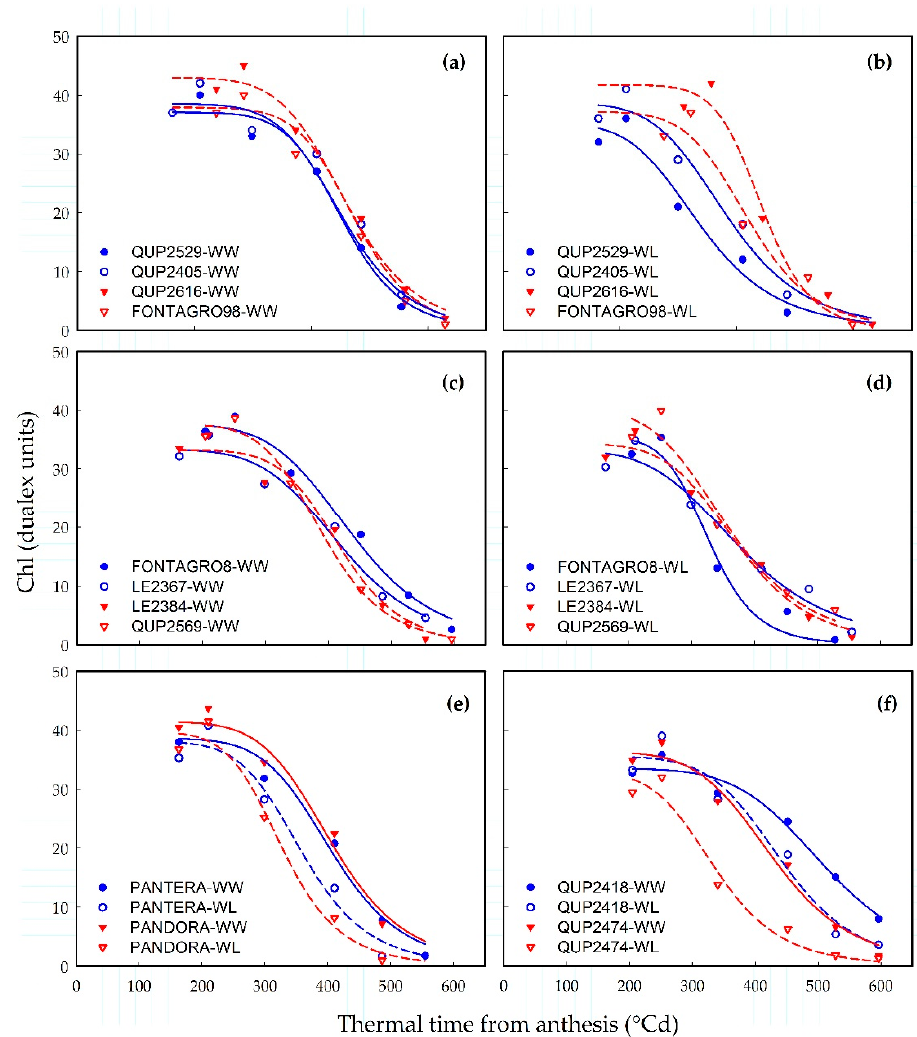
Figure 2. Dynamics of flag leaf senescence in a set of contrasting spring bread wheat genotypes from field experiment. ( a – d ) Panels highlight the variation among lines grown under ( a – c ) well-watered (WW) and ( b – d ) water-limited (WL) conditions. ( e , f ) Panels highlight the variation between water regimes. In ( a – f ) each point represent the average of three replicates but curves were fitted using individual replicates. Symbols represent measured experimental chlorophyll content index (Chl) values, whereas the lines represent the regression curves fitted with Equation (1).